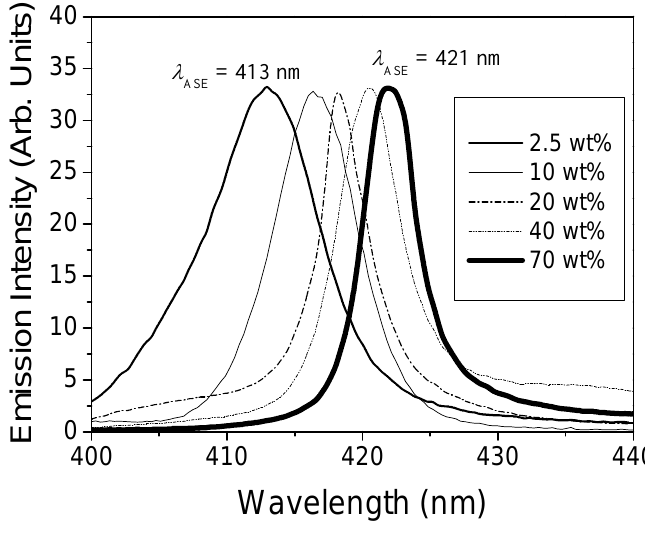
Figure 6. ASE spectra for PS films doped with various TPD